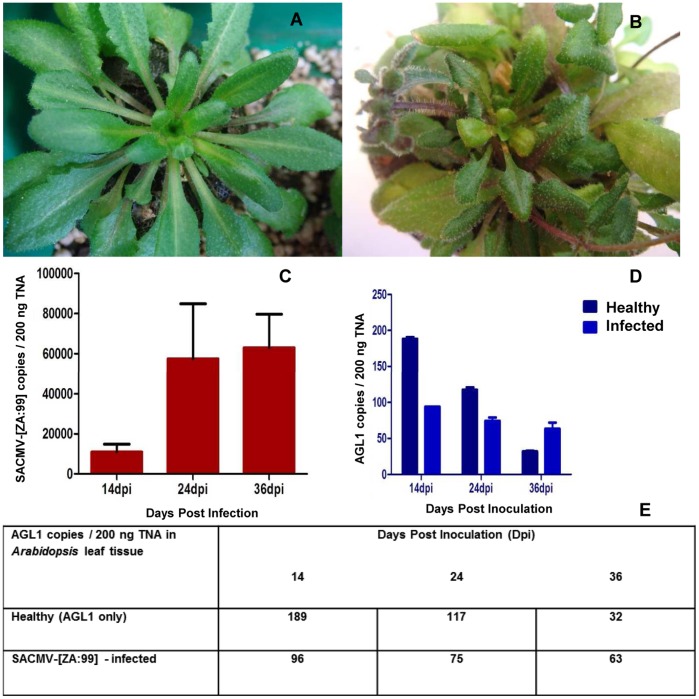
Infectivity assay of SACMV-agroinoculated Arabidopsis.
A:
 Mock-inoculated Arabidopsis plants displaying no symptoms (healthy). B: SACMV – infected leaves displaying leaf curl and deformation. C: SACMV copy number (copies/200 ng TNA) over time. Large error bars indicate variability in virus copy number due to biological differences between replicates. D and E: AGL1 detection in 200 ng of TNA from healthy and SACMV – infected leaf tissue across time points 14, 24, and 36 dpi.